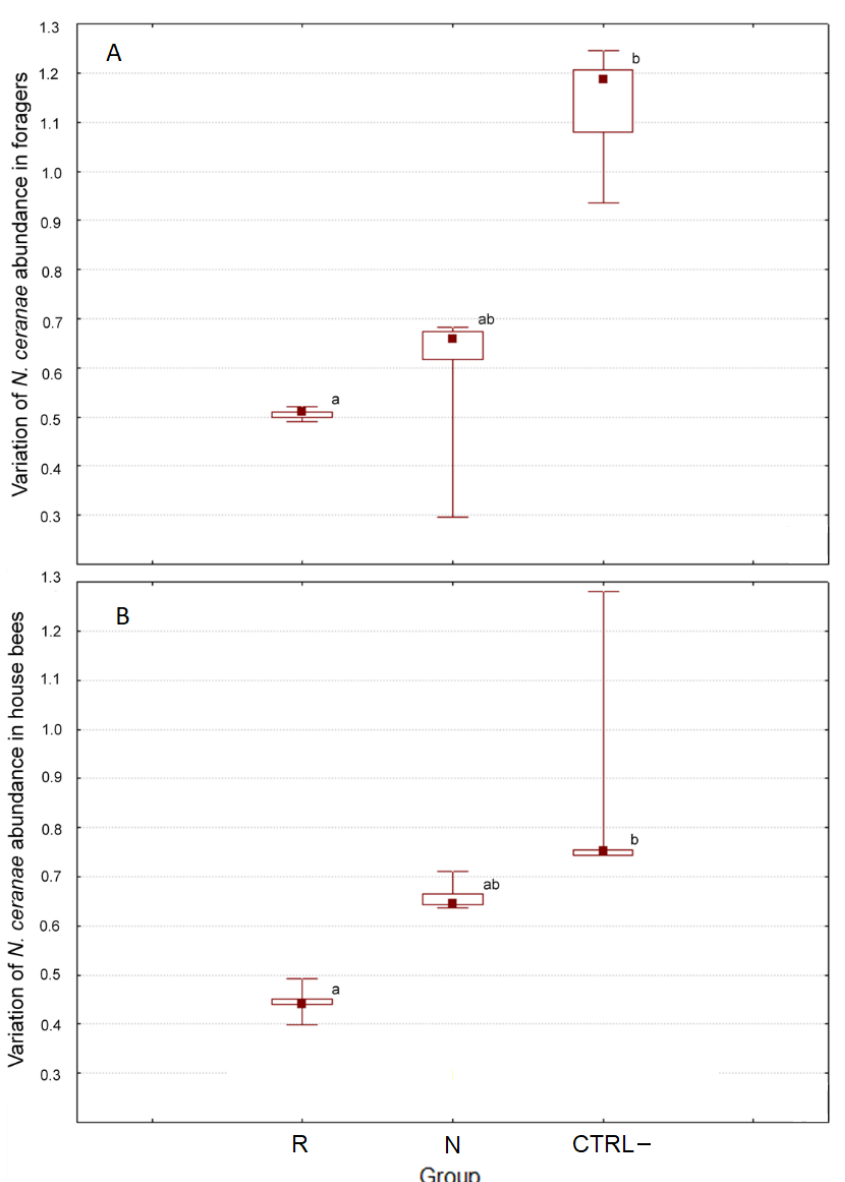
Figure 3. Post-/pretreatment variation of N. ceranae abundance in foragers ( A ) and house bees ( B ). Different letters indicate significant differences (Kruskal–Wallis H test, p = 0.05).